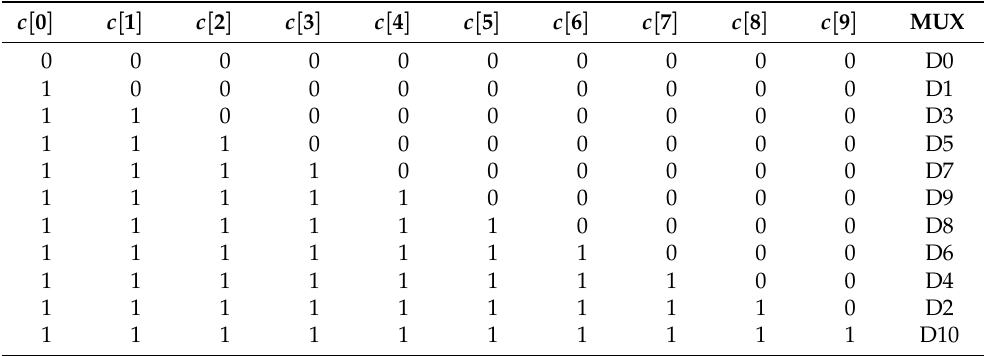
Figure 3. The overall hardware design of a piecewise linear fitting function with 10 piecewise points. Table 4. Selection method for the 11 input data of the